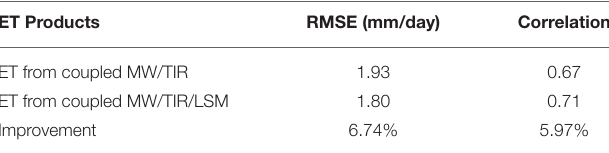
TABLE 1 | Error statistics (mean RMSE and correlation) of ET retrievals derived from MW/TIR and MW/TIR/LSM methods validated against AmeriFlux sites from